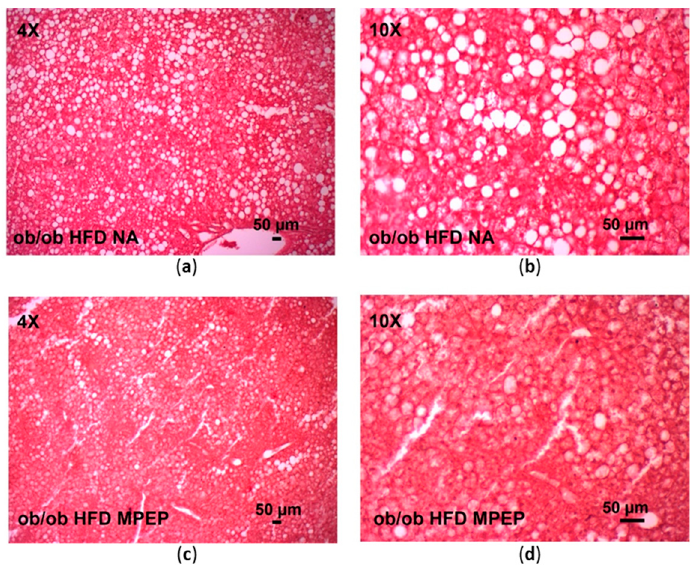
Figure 1. Hematoxylin-eosin staining of liver sections from obese mice after 7 weeks of HFD